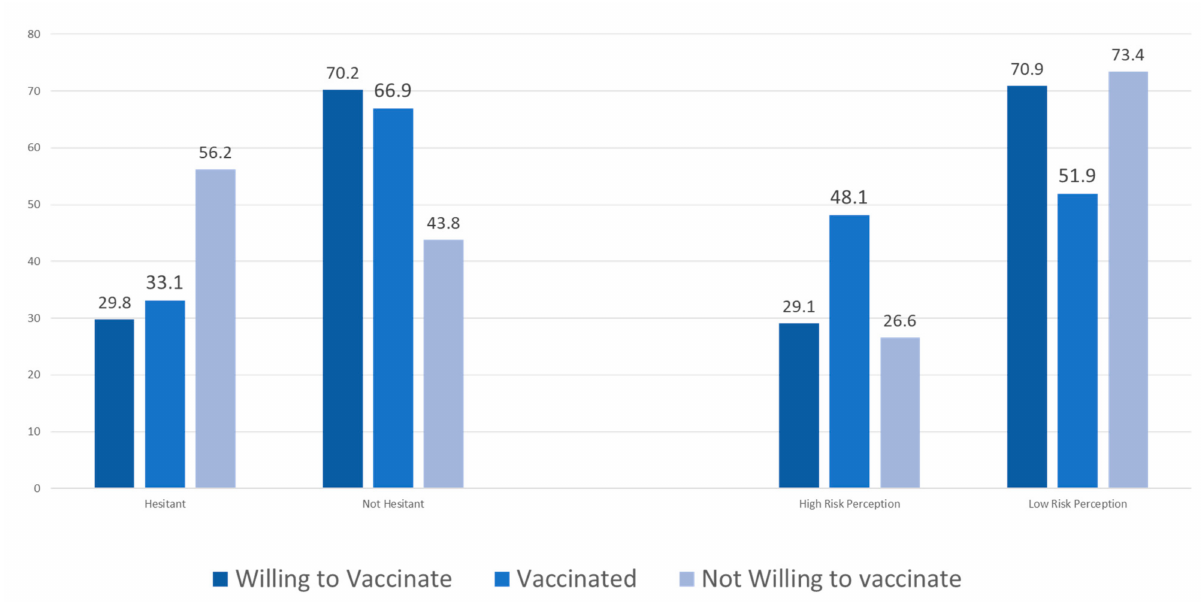
Figure 2. Comparison of perceived risk and vaccine hesitancy among participants who were not willing to be vaccinated against COVID-19, those who were willing but had not yet been vaccinated and those who had already been